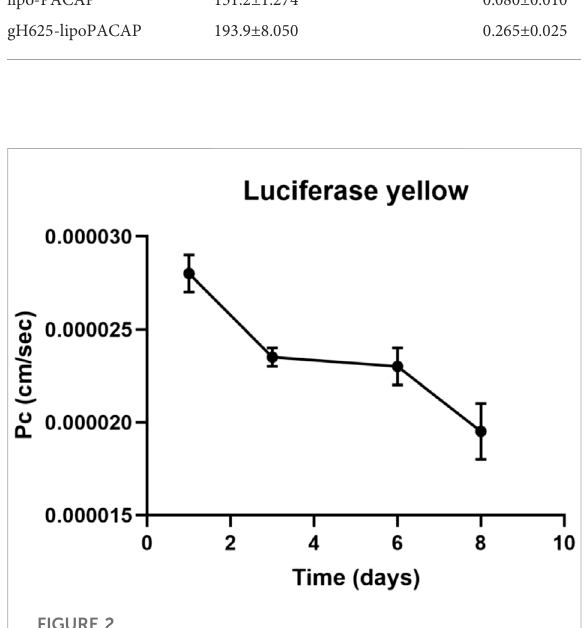
FIGURE 2 Luciferase yellow permeation through bEnd.3 monolayer cells. LY permeation decreases until day four, where it remains constant until day six to decrease until day eight. LY permeation change indicates the formation of tight